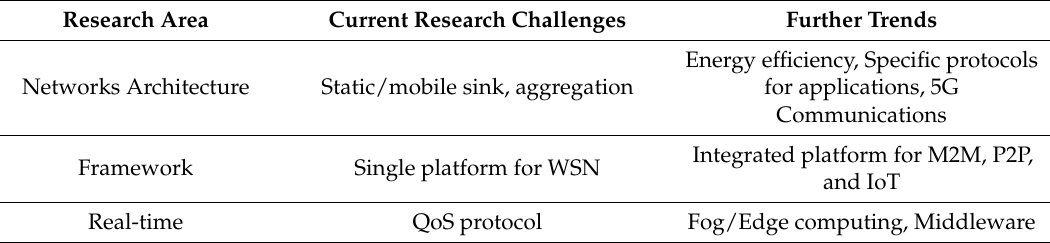
Table 4. Summary of open